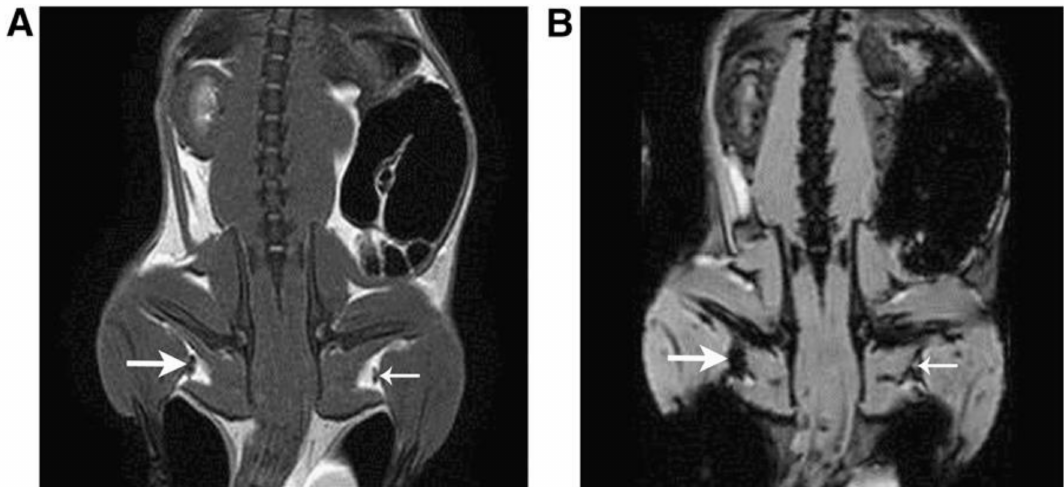
Figure 13. Representative coronal MR images of rats visualizing the sentinel lymph node (SLN) (thick arrow) at the injection side and contralateral node (thin arrow). Accumulation of tracer is clearly visible in the SLN in both a T2-weighted spin-echo (SE) pulse sequence image ( A ) and a gradient-echo (GRE) pulse sequence was used for the T2*-weighted image ( B ). Adapted with permission from [109], Copyright 2011 American Chemical